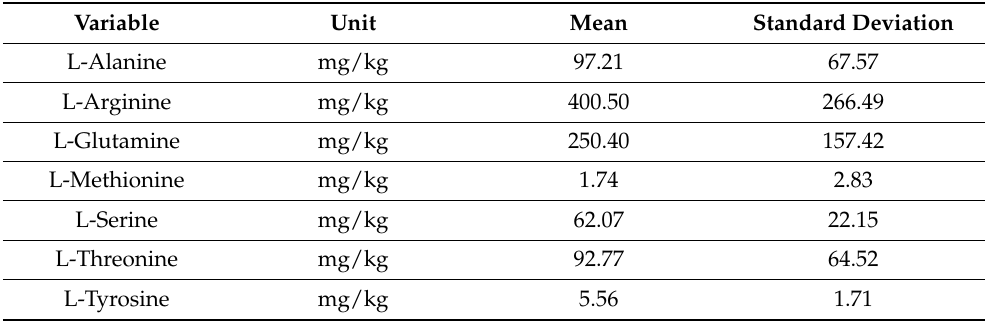
Table 7. Means and standard deviations of amino acids in grape (see Table S3 in the Supplementary Materials).